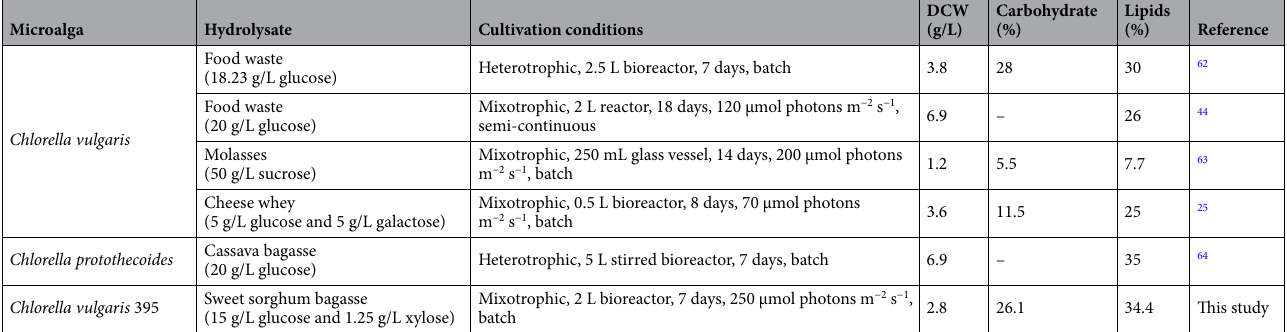
Table 2. Dry cell weight (DCW), carbohydrate content, and lipid content of Chlorella reached after cultivation in SSB hydrolysate (this study) and other biomass hydrolysates